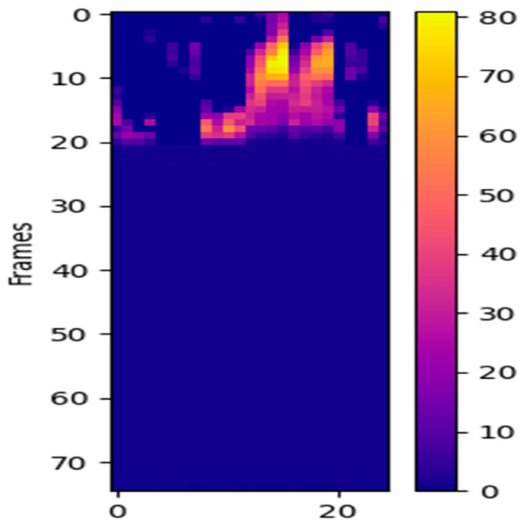
Figure 6. Sub-graph attention visualization feature map of a fall